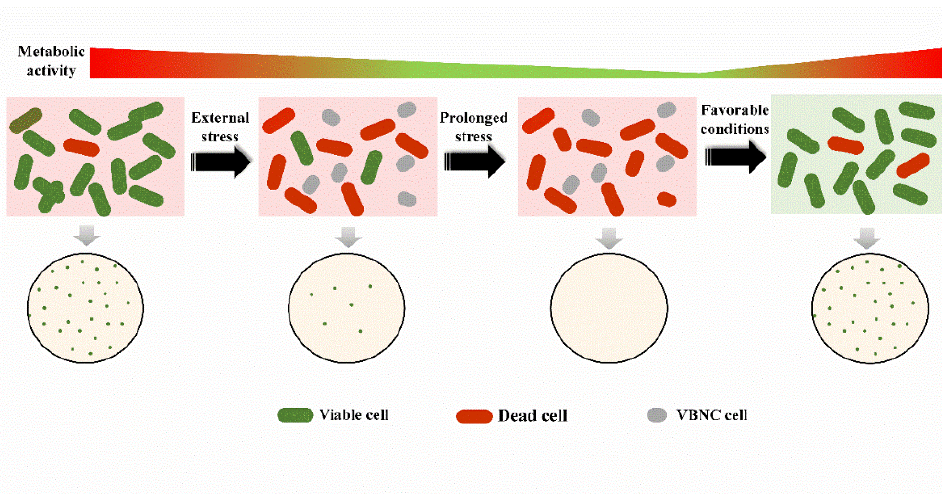
Figure 1. The formation of the VBNC state and its resuscitation. While confronted with prolonged stressful environments, a small proportion of viable bacteria will enter the VBNC state, under which bacteria cannot develop into colonies on their culture medium, but cellular metabolic activities are retained although significantly decreased. When provided with favorable conditions, VBNC cells will resuscitate to the viable state with recovered metabolic activity and culturability.